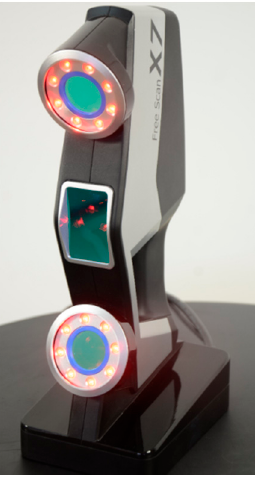
Figure 11. FreeScan X7 metrology 3D scanner.